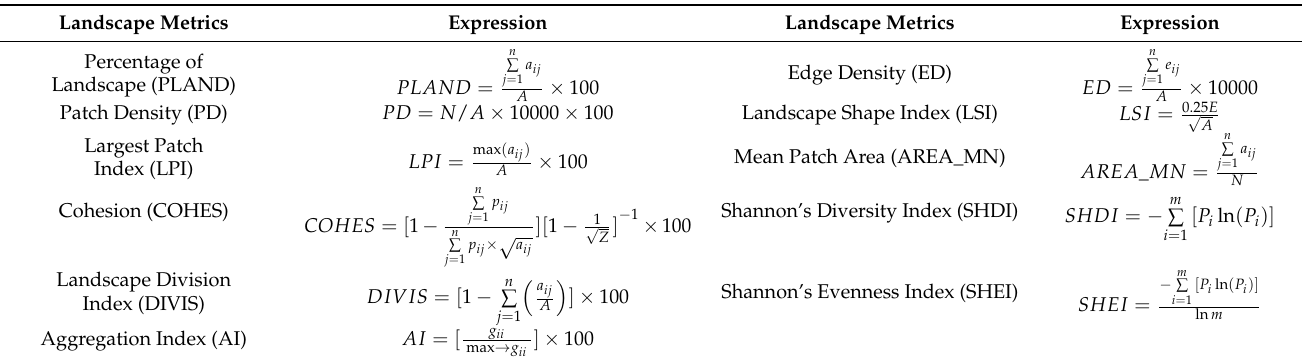
Table 1. The expression of landscape pattern index.